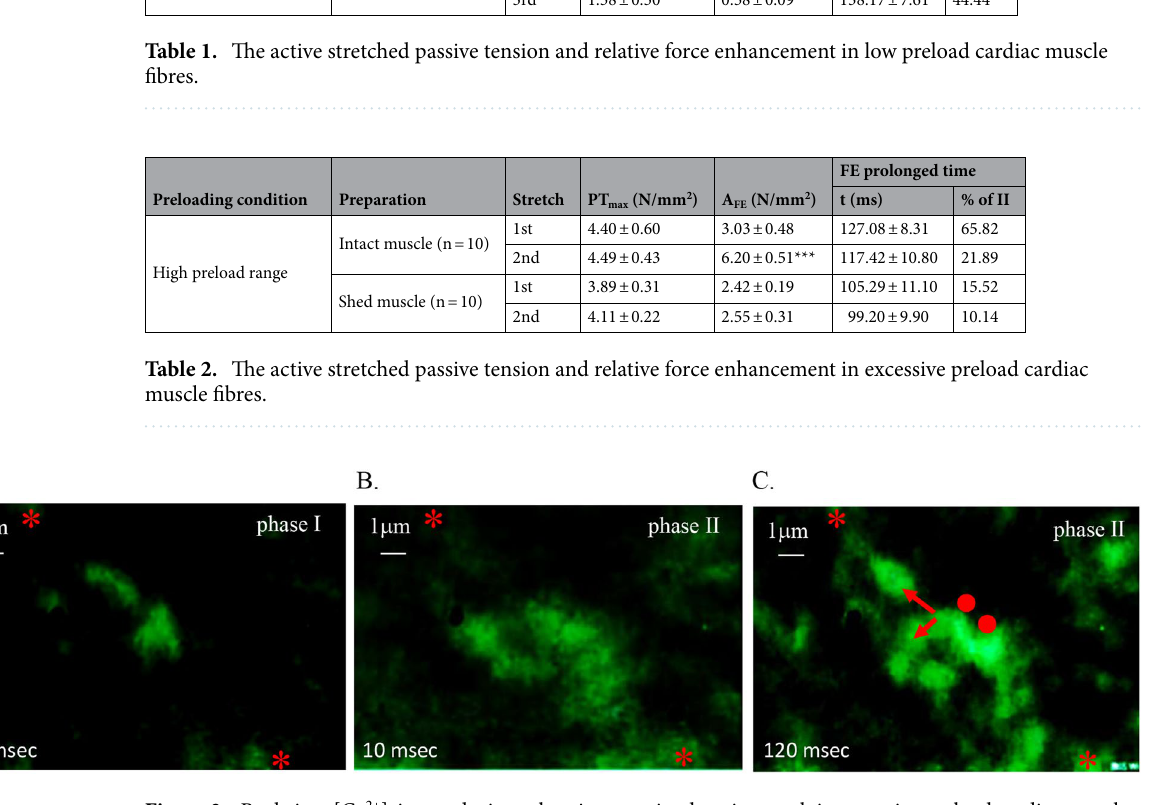
Figure 3. Real-time [Ca 2+ ] i image during tolerating sustained static stretch in excessive preload cardiac muscle fibres. ( A ) Fluorescence imaging of [Ca 2+ ] i in L l muscle fibres before active stretching. The space between * was the [Ca 2+ ] i redistribution observation area during tolerating sustained static stretch. ( B ) Fluorescence imaging of [Ca 2+ ] i primary recruitment after one active stretch. On the myograph, the passive tension is on its attenuation phase. [Ca 2+